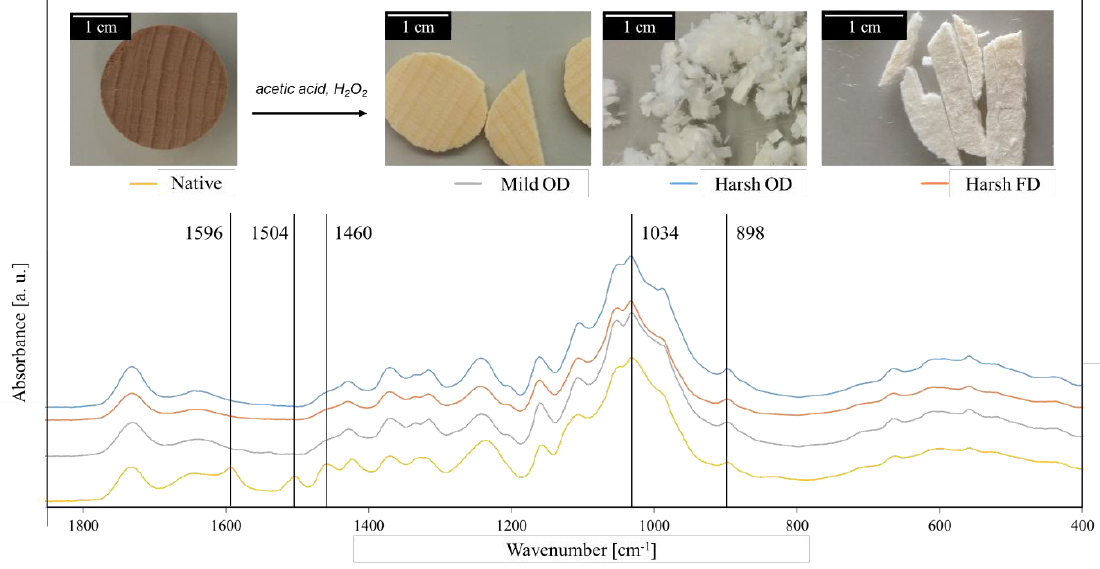
Figure 1 Delignification of beech wood samples under mild and harsh conditions, oven dried (OD) or freeze-drying (FD), and the corresponding Fourier-Transformed Infra-Red (FTIR) spectra with characteristic vibrations for lignin (1596, 1504 and 1460 cm − 1 ) and cellulose (1034 and 898 cm − 1 ).